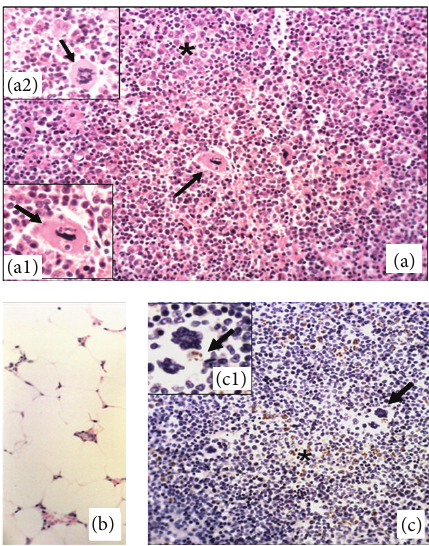
Figure 1: Photomicrographs of the bone marrow of dogs with visceral leishmaniasis. (a) Granuloma ( ∗ ), megakaryocytic emperipolesis(arrow,(a1),groupO),anddysplasticmegakaryocytes ((a2), group O). (b) Bone marrow with severe aplasia (group A); hematoxylin and eosin, objective 40x. (c) Immunolabeling of amastigote forms of L. chagasi in macrophages ( ∗ ); detail of megakaryocytic emperipolesis with an immunolabeled amastigote form(arrow,(c1);symptomaticdog);streptavidin-biotin-peroxidase complex, objective